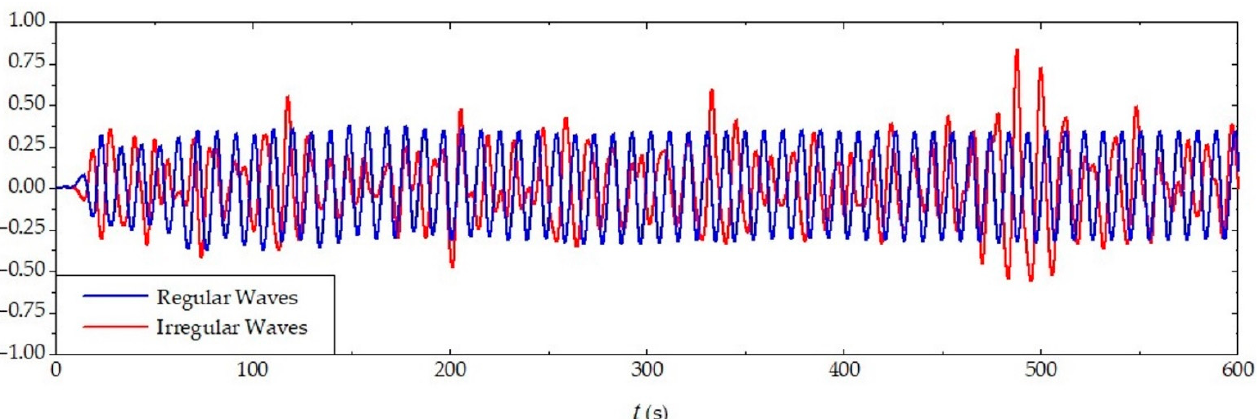
Figure 11. Free-surface elevation obtained with representative regular waves and realistic irregular waves for SVP. Figure 12. Free-surface elevation obtained with representative regular waves and realistic irregular waves for TV. From Figures 10–12, as expected, the free-surface elevation caused by the generation of representative regular waves presents constant wave peaks for the three cases. On the other hand, the elevation caused by the generation of realistic irregular waves presents